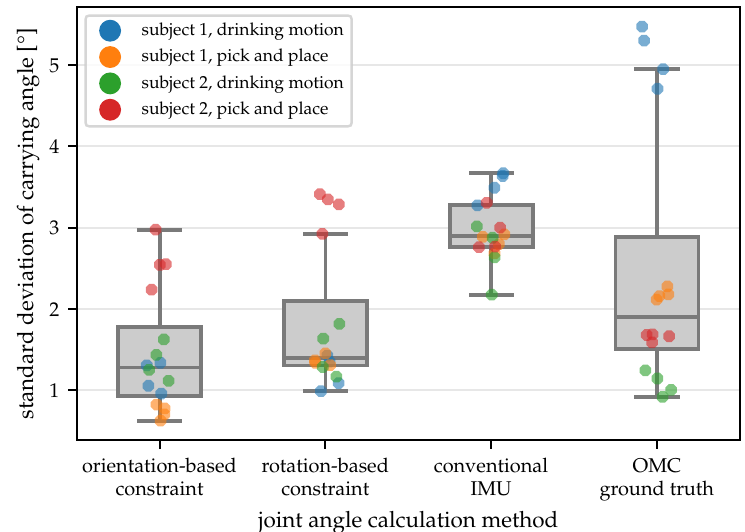
Figure 11. Standard deviation of the carrying angle for all trials with the different angle calculation methods. The proposed method induces the smallest variation in the assumed-to-be-constant carrying angle. This indicates that the estimated joint axes describe the functional motion axes better than the axes obtained via careful manual IMU placement (conventional IMU) and via placing markers on anatomical landmarks (OMC ground